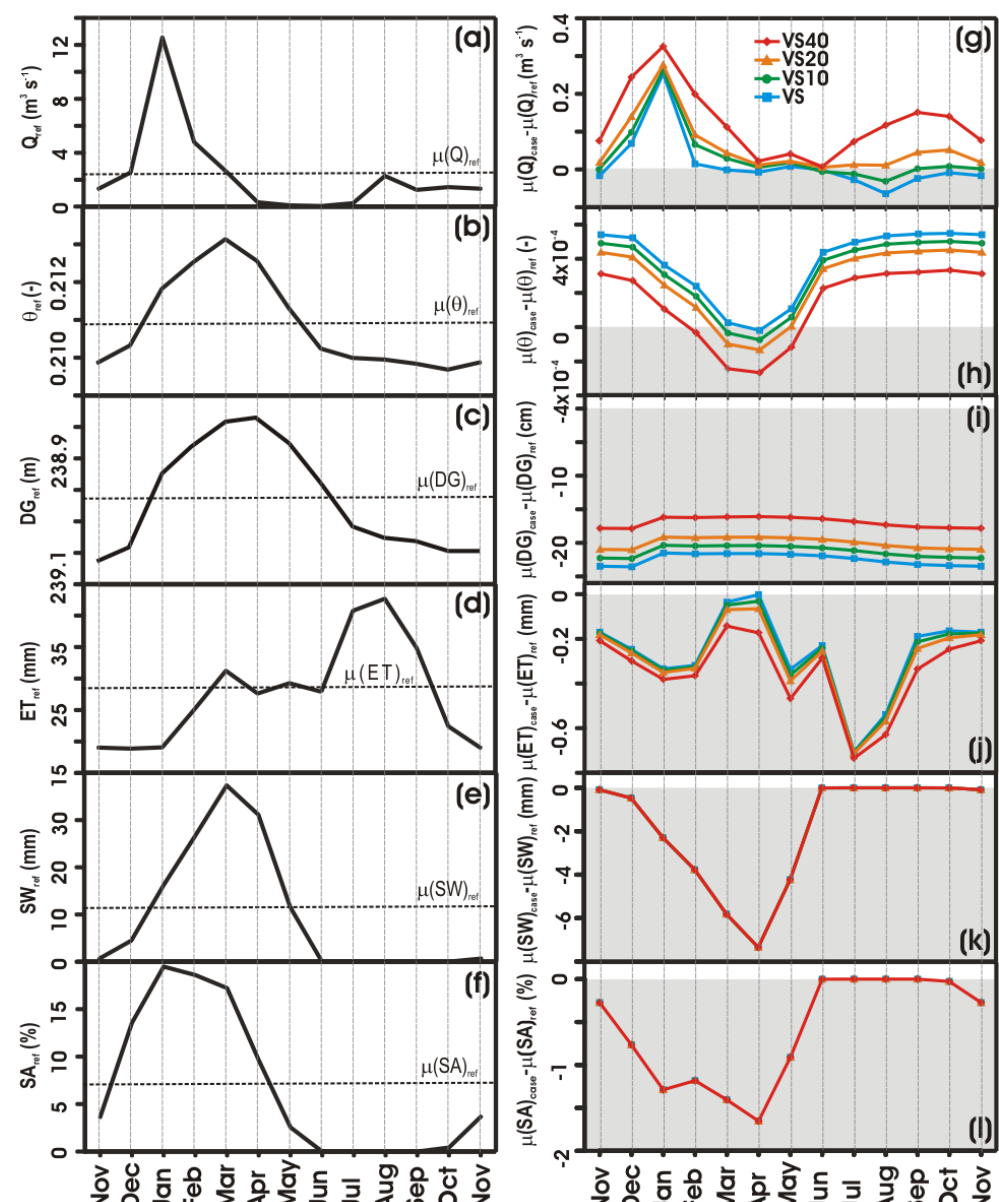
Figure 11. Mean monthly values of (a) outlet streamflow ( Q ref ), (b) vadose zone soil moisture ( θ ref ), (c) depth to groundwater (DG ref ), (d) evapotranspiration (ET ref ), (e) snow water equivalent (SW ref ) and (f) snow covered area (SA ref ), for the reference case as computed from 20-year (1991–2010) model simulations and integrated over the entire basin area; mean annual values are represented by dashed lines in each plot. Mean monthly differences µ(X) case /µ(X) ref between thinning simulated (V in blue, VS10 in green, VS20 in orange and VS40 in red) and reference case (zero value) are illustrated for (g) outlet streamflow µ(Q) case /µ(Q) ref , (h) vadose zone soil moisture µ(θ) case /µ(θ) ref , (i) depth to groundwater µ( DG ) case /µ( DG ) ref , (j) evapotranspiration µ( ET ) case /µ( ET ) ref , (k) snow water equivalent µ( SW ) case /µ( SW ) ref and (I) snow covered area µ( SA ) case /µ( SA )